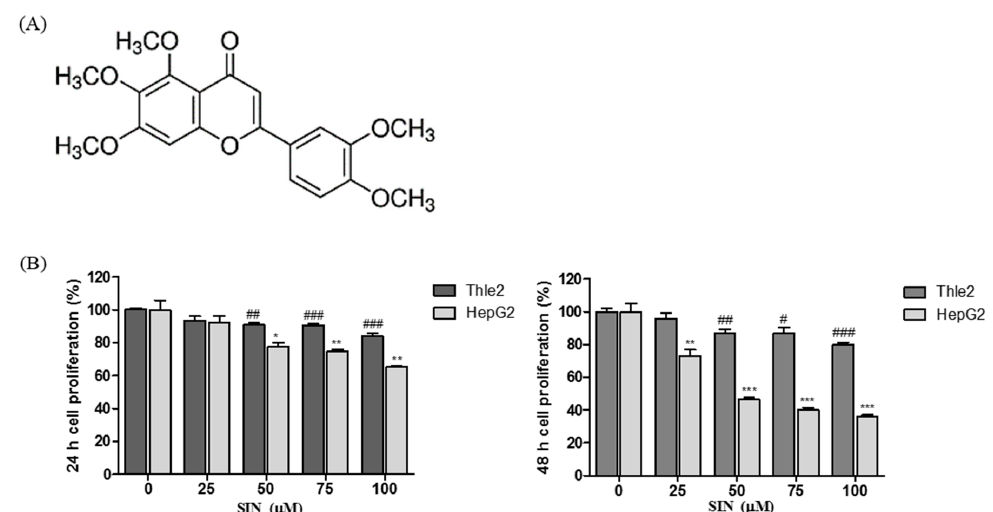
Figure 1. The chemical structure of sinensetin (SIN) and the e ff ect of SIN treatment in HepG2 and Figure 1 Thle2 cells. ( A ) Structure of SIN; ( B ) HepG2 and Thle2 cells were treated with indicated concentrations of SIN (0, 25, 50, 75, and 100 µ M) for 24 h or 48 h, and cell viability was determined by the MTT